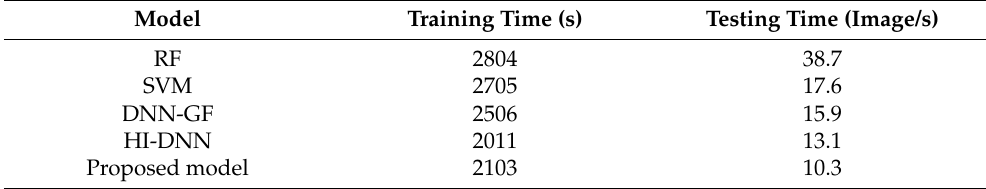
Table 8. Training and testing time analysis.